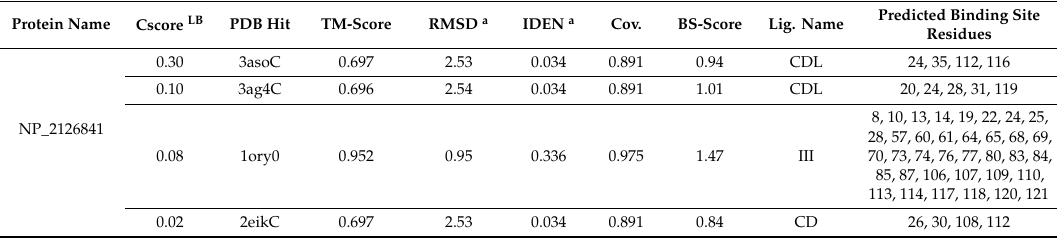
Figure 4. B-cell epitope in the FLiS protein based on Parker hydrophilicity prediction ( A ). Bepipred linear epitope ( B ). Chou and Fasman β -turn prediction ( C ). Emini surface accessibility prediction ( D ). Karplus and Schulz flexibility prediction ( E ). Kolaskar and Tongaonkar antigenicity ( F ). The x-axis and y-axis represent the sequence position and corresponding antigenic properties score, respectively. The threshold level was set as default parameter of the server. The regions shown in yellow color above the threshold value were predicted as B-cell epitope. Table 4. The predicted binding site for vaccine candidates and their interacting residues using the COFACTOR